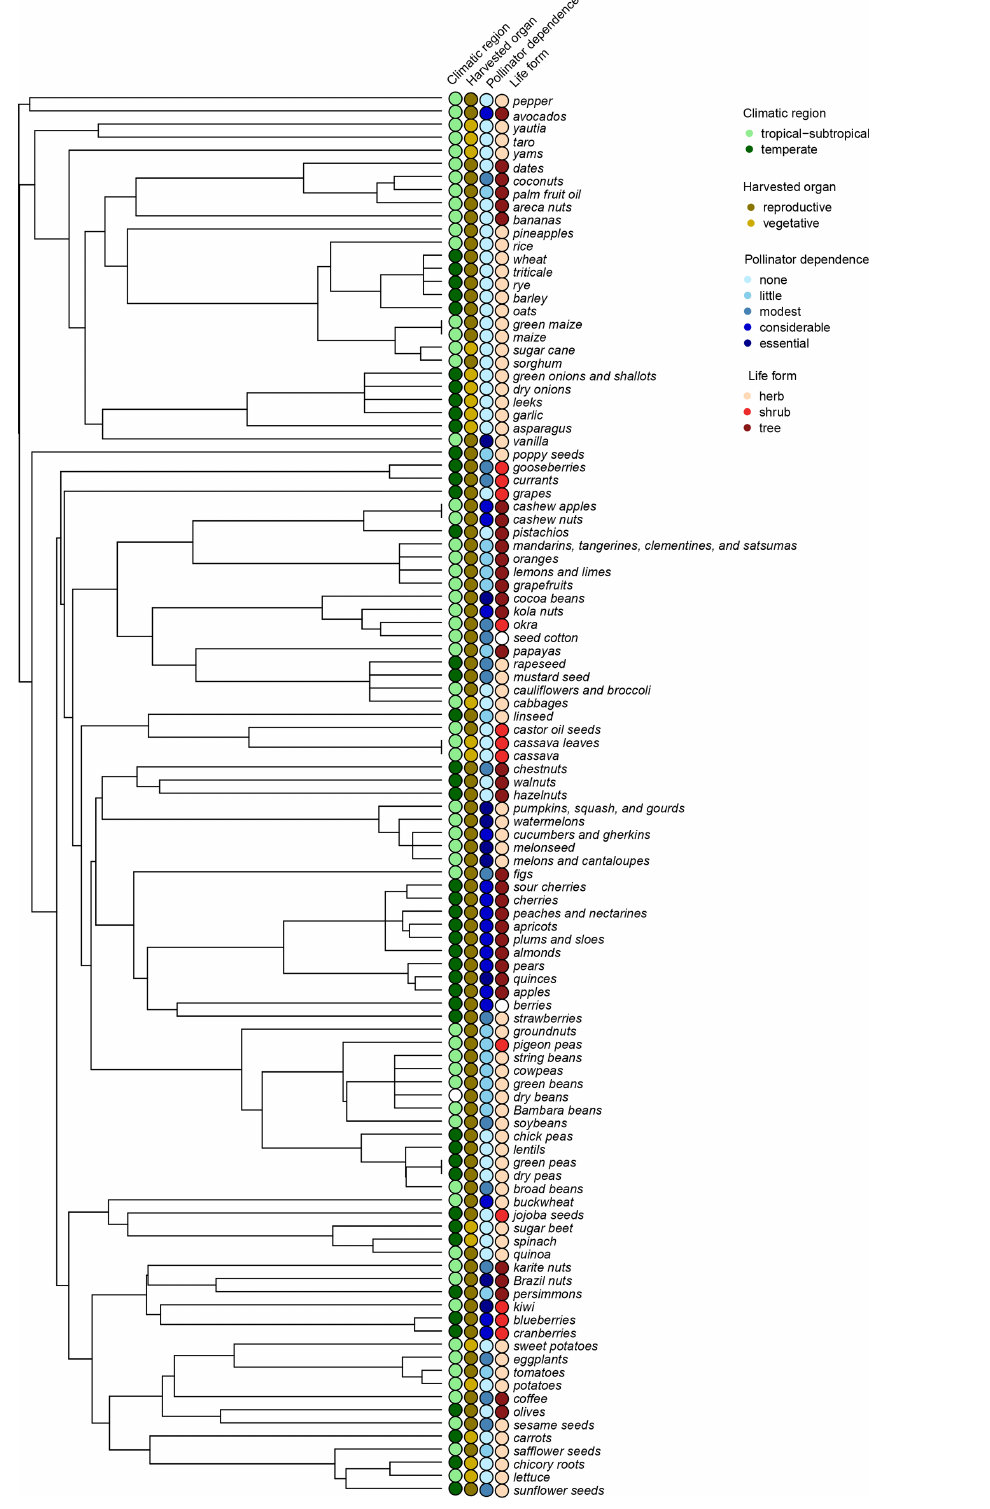
Figure A1. Phylogenetic relationships among all FAO items included in the study. Data on climatic region, harvested organ, pollinator dependence, and crop life form are indicated for each tip. Unfilled circles depict tip data that have been excluded from the analyses, as they corresponded to FAO items comprising species that differ in a given